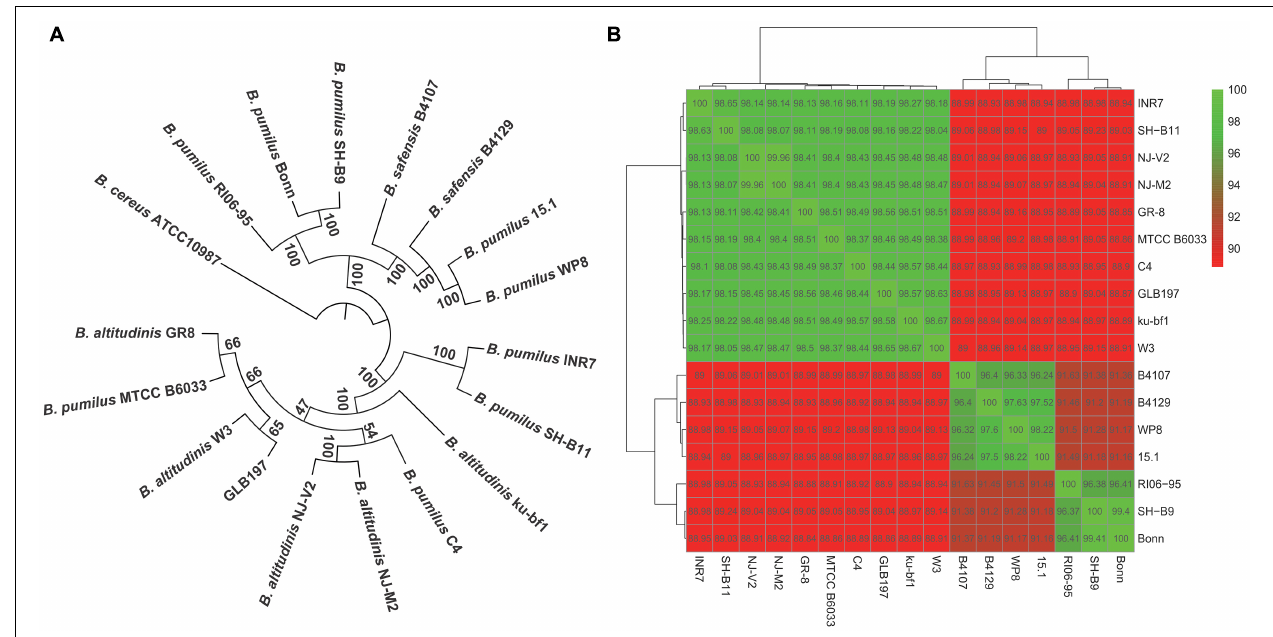
FIGURE 2 | Phylogenetic tree of Bacillus . (A) Maximum likelihood tree of different Bacillus constructed based on 1,226 single-copy core proteins shared by 17 genomes and an outgroup ( Bacillus cereus ATCC 10987). The phylogenetic tree was rooted by the outgroup. Support values of phylogenetic tree are shown for nodes as maximum likelihood bootstrap. (B) Heat map of average nucleotide identity values among different strains of Bacillus revealing three groups.